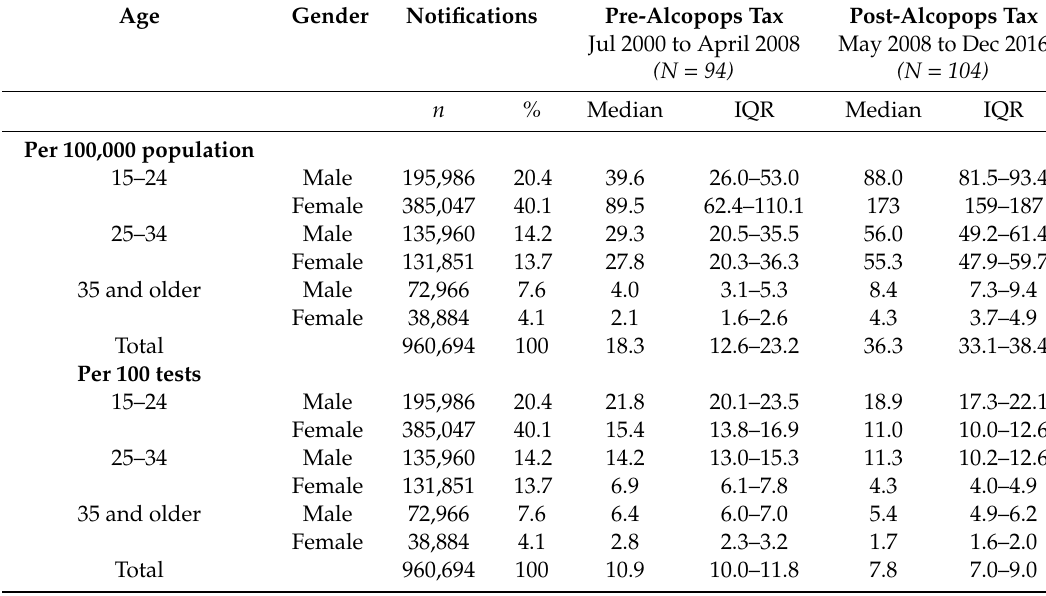
Table 1. Descriptive statistics for monthly chlamydia rates per 100,000 (primary outcome) and per 100 tests (secondary outcome) pre- and post-alcopops tax intervention (27th April 2008), by age group and gender. Age Gender Notifications Pre-Alcopops